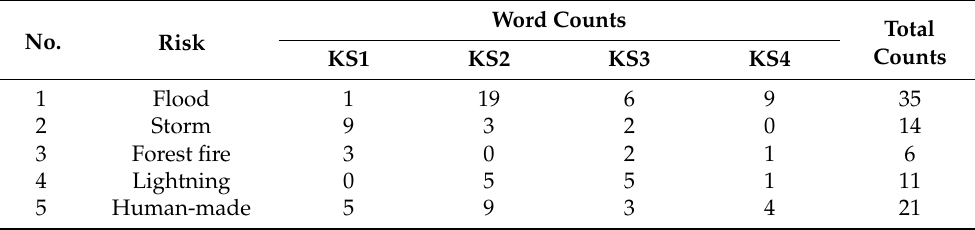
Table 6. Word counts of climate and human-made risks in the scripts of in-depth